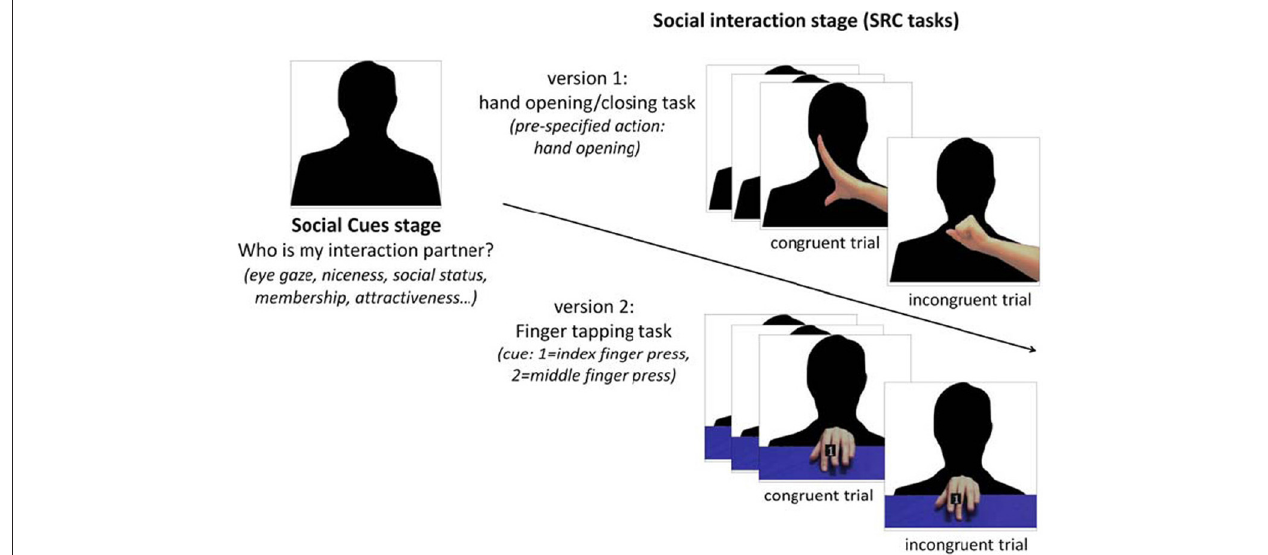
FIGURE 1 | A social SRC paradigm. In this paradigm, participants have to learn about a person (via vignettes or videos) at first (“social cues stage”) and then play a SRC task with that person in videos (“social interaction stage”). Two versions of SRC tasks are